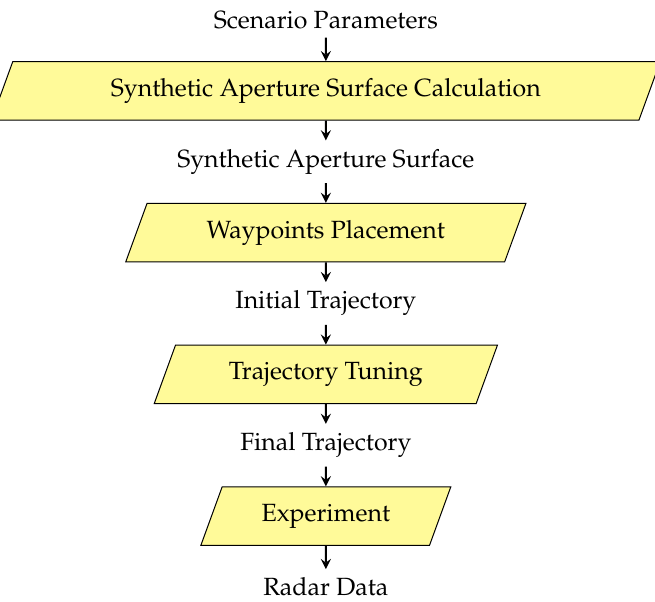
Figure 9. General diagram of three-dimensional (3D) Synthetic Aperture Radar